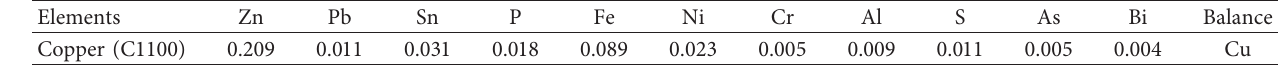
Table 1: Chemical compositions of the copper (C1100) alloy in wt%.